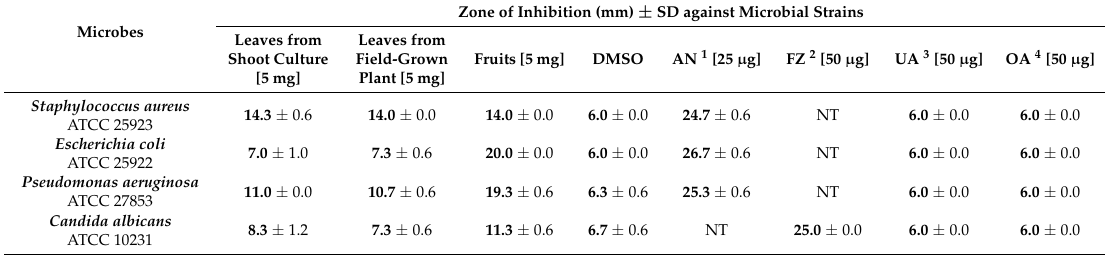
Figure 4. Inhibition effect of Chaenomeles japonica extracts on microbes A-leaves of micropropagated plantlets (shoot culture); B—leaves of field-grown plant; C—fruit; D—DMSO (dimethyl sulfoxide); E—ursolic acid; and, F—oleanolic acid. Table 6. Antimicrobial activity of Chaenomeles japonica extracts.